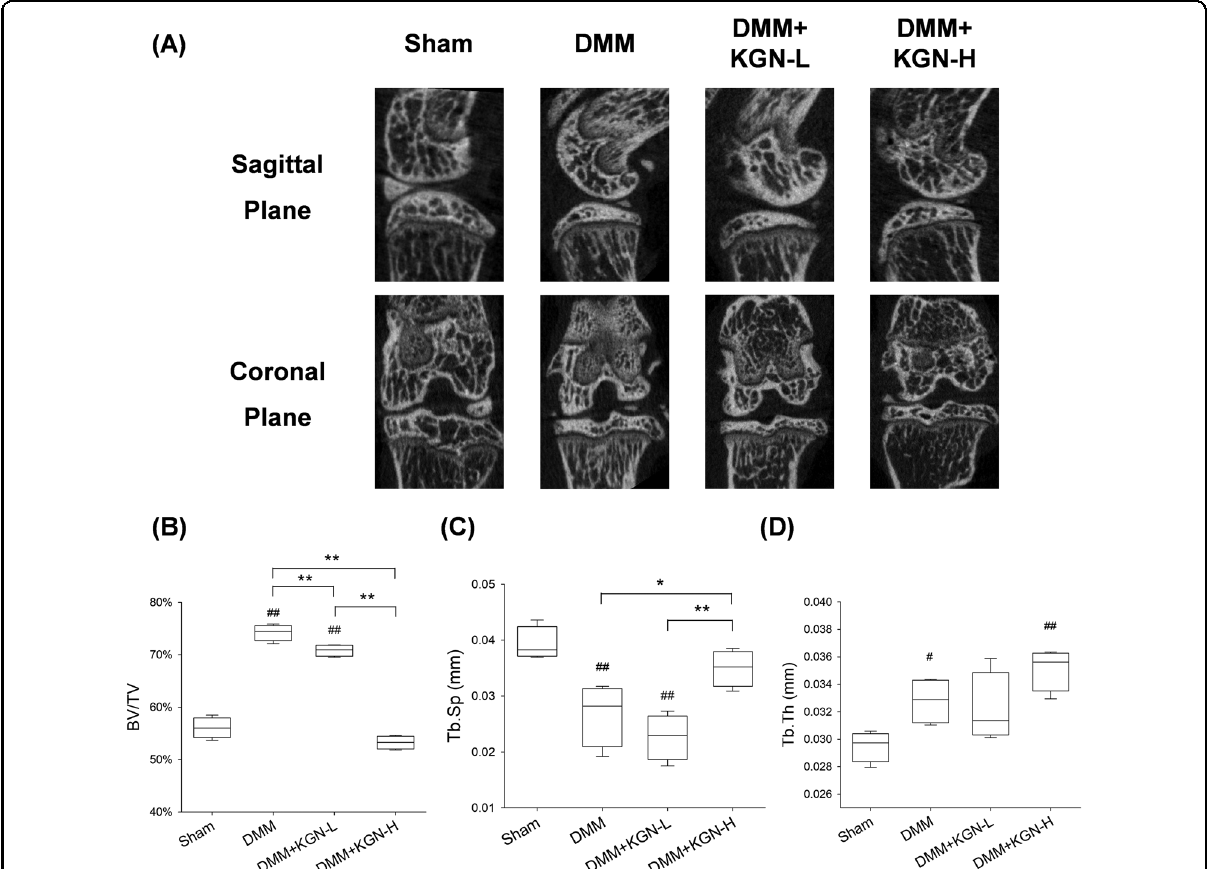
Fig. 4 Effect of intra-articular injection of KGN on the sclerosis of subchondral bone in DMM-induced OA in mice. The DMM-op mice were injected with 1 μ M or 100 μ M of KGN, twice a week for four weeks, while the control groups were injected with 10 μ L of saline. A Representative Micro-CT images of medial and coronal planes of femoral condyle and tibial plateau in mice with OA. B – D The effects of KGN on subchondral bone parameters including B the bone volume ratio (BV/TV, %), C trabecular separation (Tb.Sp., mm) and D trabecular thickness (Tb.Th., mm). Values represent mean ± S.E.M of four replicas. (* p < 0.05 and ** p < 0.01; between the indicated groups and # p < 0.05 or ## p < 0 . 01 versus the CTRL